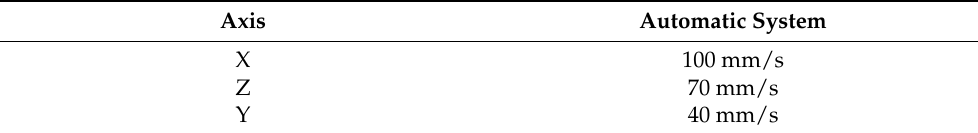
Table 7. Actuators